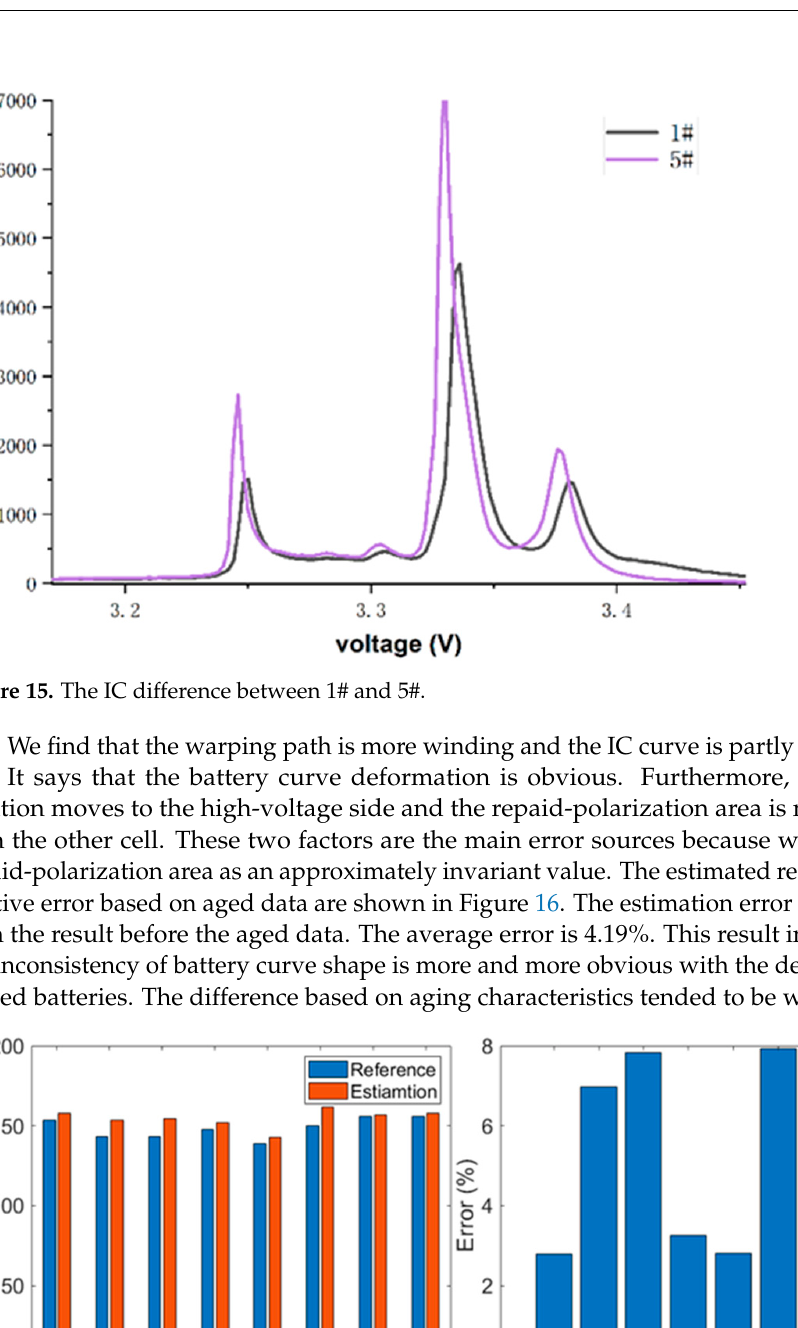
Figure 14. Curve-matching relation between 1# and 5#.